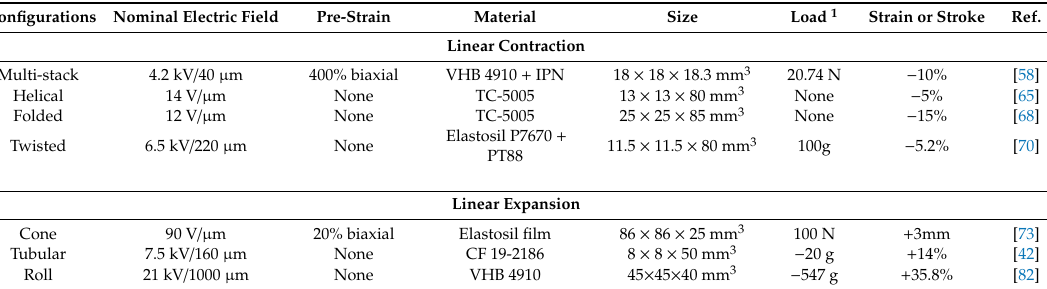
Figure 6. Schematics of Linear Expansion DEA. Transparent: Elastomers, Black: Electrodes ( a ) Cone actuator; ( b ) Tubular actuator; ( c ) Roll actuator. Table 3. Maximum performance of DE artificial muscle design.